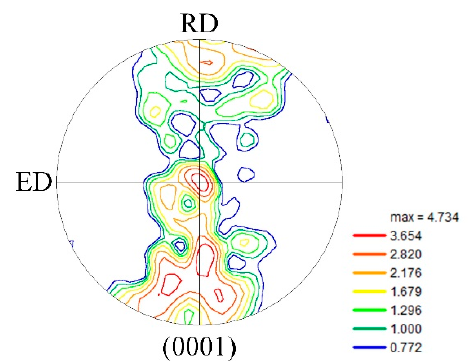
Figure 3. PF map after 10% tensile strain in Mg–8.0Gd–3.0Y–0.5 Zr alloy.